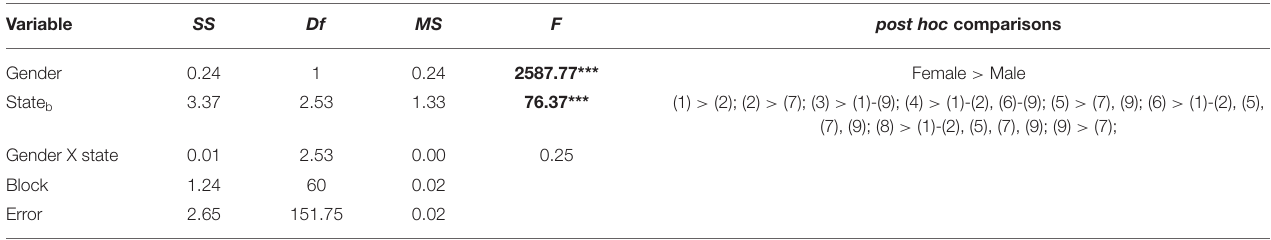
It indicates that b is the interval design factor (dependent factor). (1) neutral (2) exuberant (3) bored (4) dependent (5) disdainful (6) relaxed (7) anxious (8) docile (9) hostile. *** p < 0.001. TABLE 5 | Test of simple main effect in the mixed design of gender and emotional state in Fo. Variable